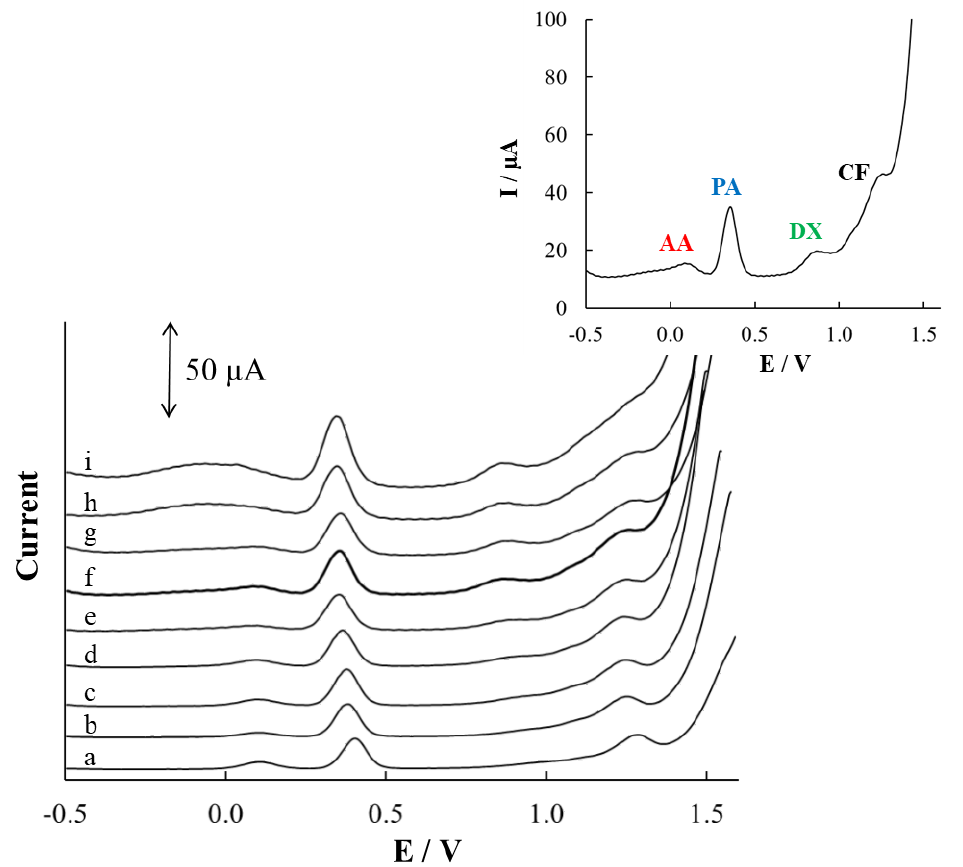
Figure 1. Differential pulse voltammetric measurements of 25 mg L − 1 ascorbic acid, paracetamol, dextromethorphan and caffeine solutions performed in 0.1 mol L − 1 acetic/acetate buffer at different pH values: (a) pH 3.75; (b) pH 4.00; (c) pH 4.25; (d) pH 4.50; (e) pH 4.75; (f) pH 5.00 (inset); (g) pH 5.25; (h) pH 5.50 and (i) pH 5.75.